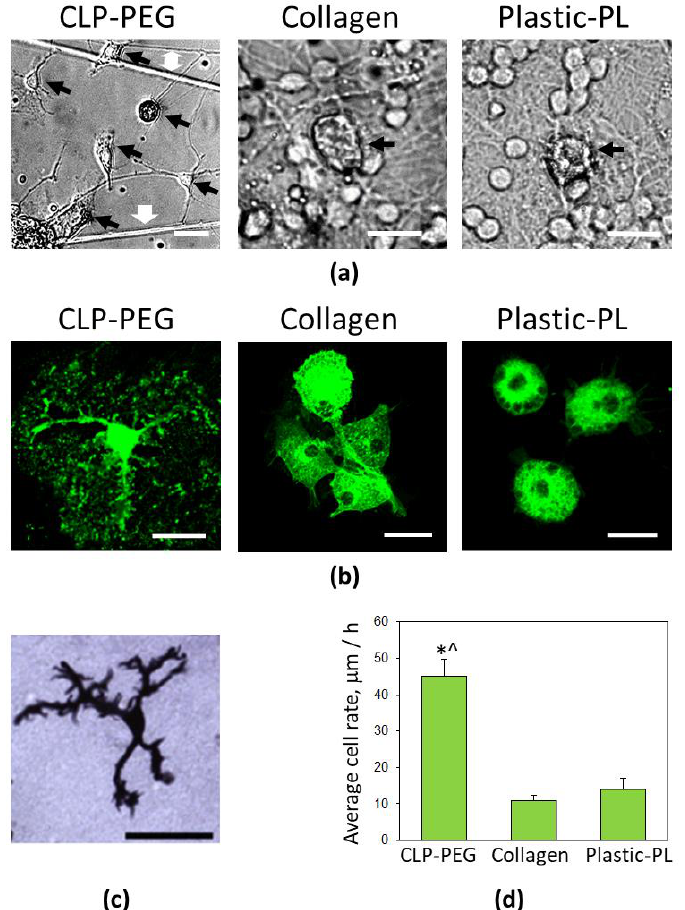
Figure 6. Representative images of microglial morphology and motility on CLP-PEG and collagen hydrogels. In ( a ), phase contrast brightfield images of living microglia in cerebellar cultures on 7th day in vitro. Black arrows point to microglia, white arrows—to neurite fibres. In ( b ), fluorescent microglial images were visualized by isolectin GS-IB 4 in fixed cerebellar cultures on the 7th day in vitro. In ( c ), an image of a ramified microglial cell in rat cerebellum at postnatal day 12 [22] is presented for comparison, with the kind permission of prof. Margaret M. McCarthy. All scale bars are 25 μ m. In ( d ), quantitative evaluation of microglial motility. * — denotes statistically significant difference compared to the collagen samples; ^ — compared to plastic-PL samples; p < 0.001.